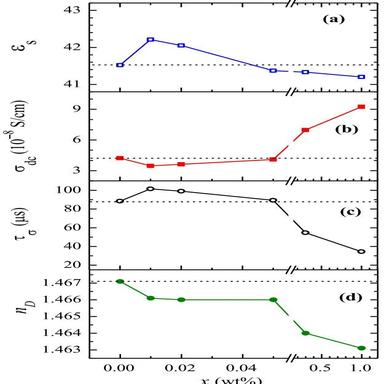
Plots of es, rdc, sr, and nD with x (wt%) amounts of ZnO for the GLY/x (wt%) ZnO nanofluids, at 25 C.